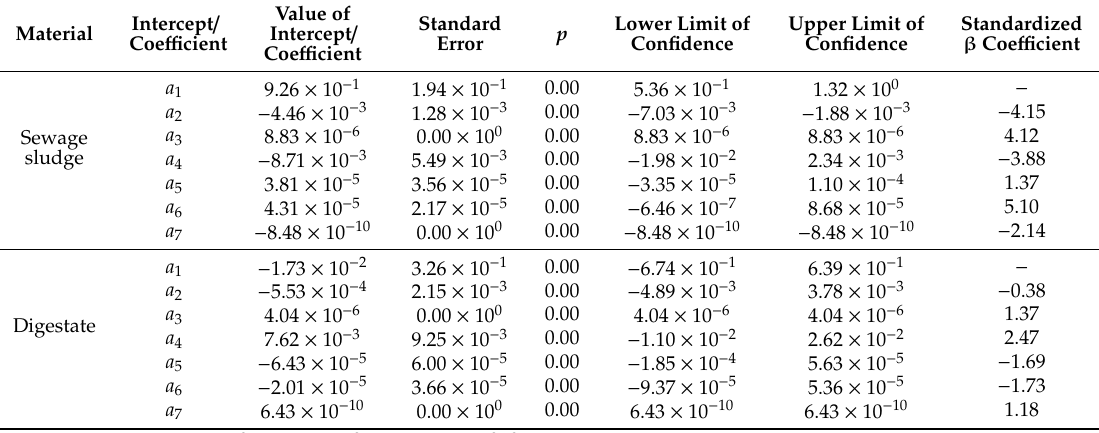
Table A5. Statistical evaluation of model coe ffi cients for the ash content in CSF from sewage sludge and digestate. Material